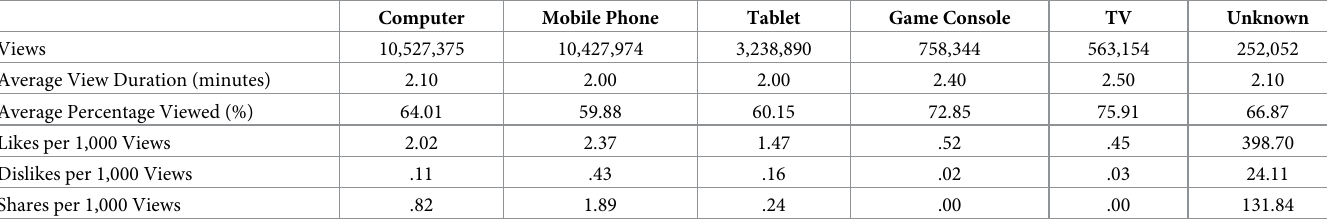
Table 3. User engagement by access device type.